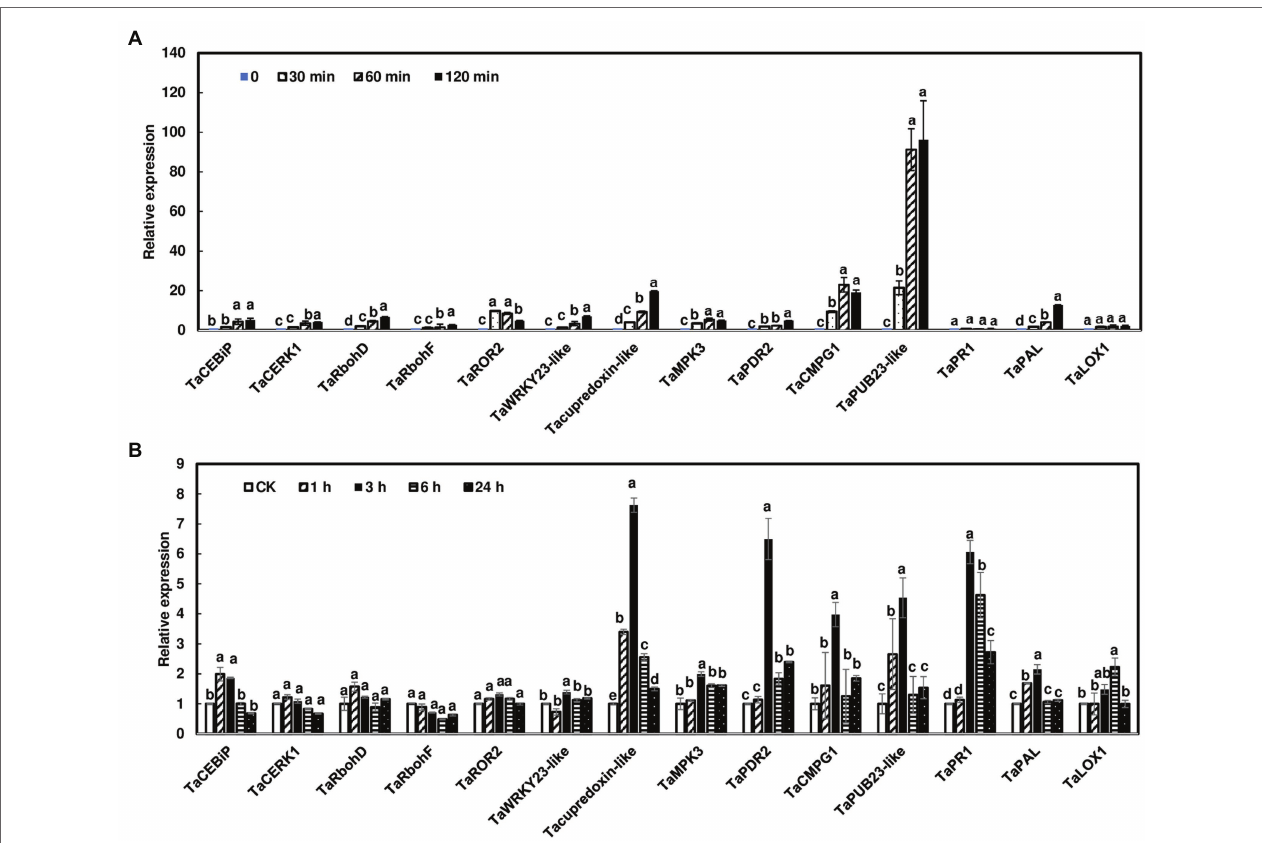
FIGURE 5 | Induction of defense marker genes in wheat heads and rachis nodes treated with chitin. (A) Rachis nodes from Norm were dissected from flowering heads and placed in water overnight to avoid wound responses. The rachis nodes were treated with 100 μ g/ml chitin for 0, 30, 60, and 120 min. Each treatment contained about 80 rachis nodes. (B) Wheat heads on live plants from Norm were dipped into .02% Tween with 100 μ g/ml chitin or without chitin as controls. Heads were collected at 1, 3, 6, and 24 h. Each treatment contained three heads. The relative quantity of genes was determined using reverse transcriptase real-time PCR (RT-PCR). Wheat gene glyceraldehyde-3-phosphate dehydrogenase ( TaGAPDH ) was used as an internal control for transcript normalization. Gene induction fold was calculated relative to a mock control. The mean of expression for each gene was calculated and compared by one-way ANOVA and Tukey’s HSD post-hoc test using JMP15 ( n = 3; p < .05). Different letters indicate significant